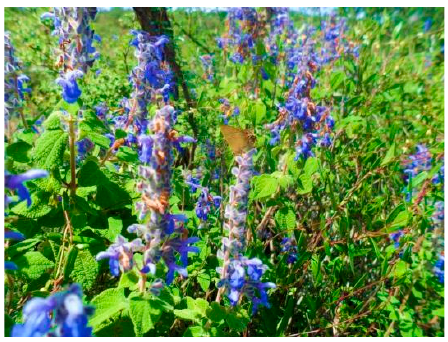
Figure 1. Salvia connivens